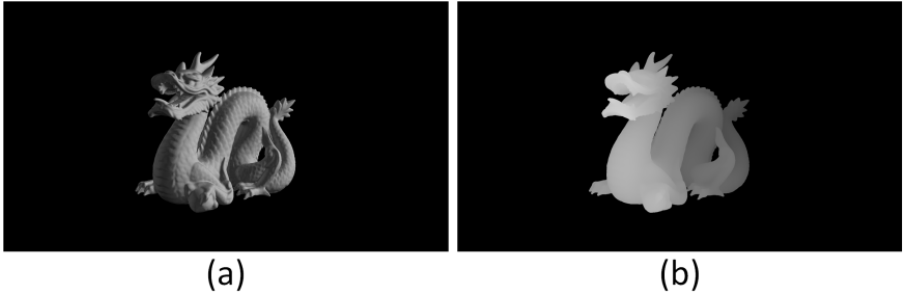
Figure 4. ( a ) ‘dragon’ and ( b ) its depth map are used to represent 2 different depth layers of the 3D scene.